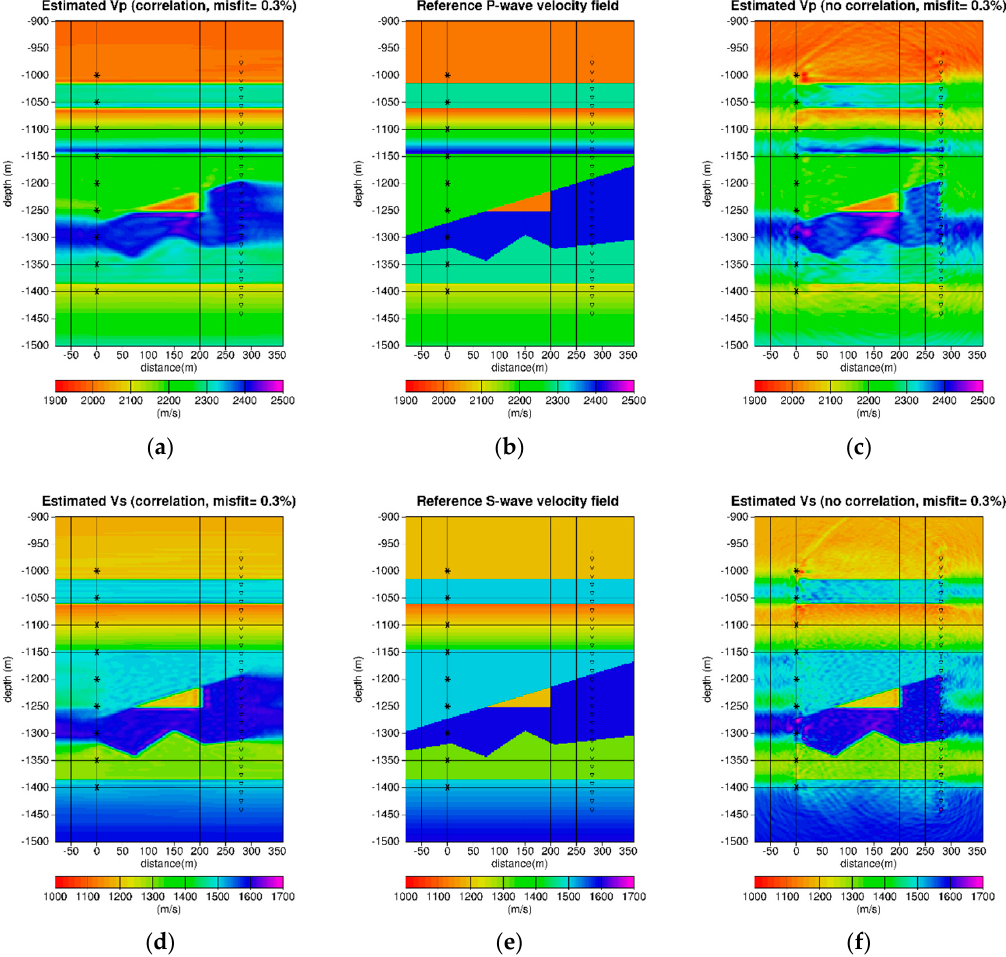
Figure 8. Comparison between results from the constrained inversion using the multiscale inversion process results of the multiscale inversion process and results from the unconstrained inversion: ( a ) The estimated P-wave velocity field for the multiscale inversion for a misfit of 0.3%; ( b ) the reference P-wave velocity field; ( c ) the estimated P-wave velocity field for the unconstrained inversion for a misfit of 0.3%; ( d ) the estimated S-wave velocity field for the multiscale inversion for a misfit of 0.3%; ( e ) the reference S-wave velocity field; ( f ) the estimated S-wave velocity field for the unconstrained inversion for a misfit of 0.3%. Both P- and S-wave estimated fields show that the multiscale inversion results are smoother than the unconstrainted inversion results, with well artifact and better reliability. The main artifacts are near the sources, below the triangle structure, above the source or receiver zones and below (less visible due to the color range), and in the constant gradient 1D layers. As expected, there is no additional information outside the square delimited by the wells for the case of unconstrained inversion.